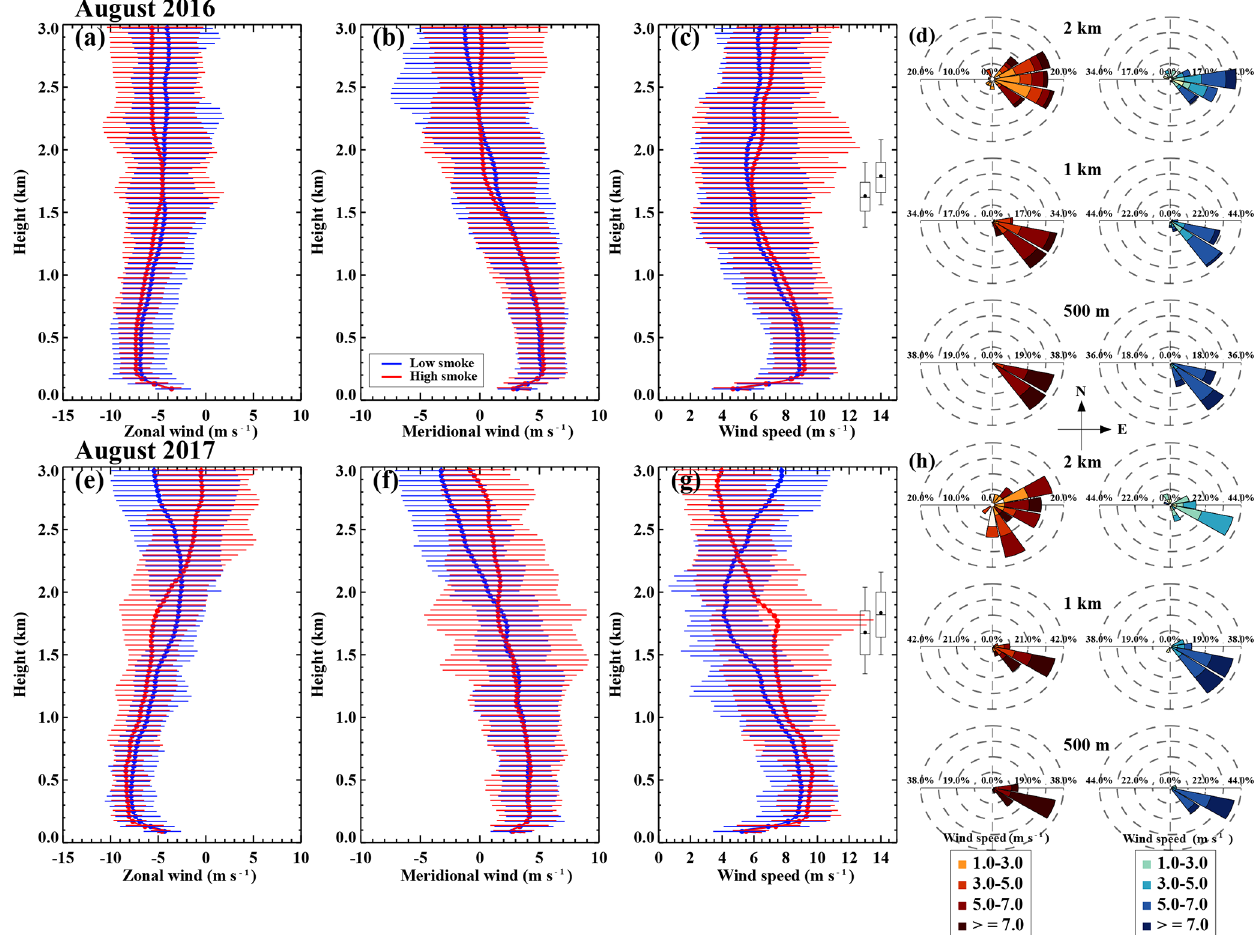
Figure 17. Radiosonde-derived (a, e) zonal wind profiles, (b, f) meridional wind profiles, and (c, g) mean wind speed profiles, for Au- gust 2016 (a–d) and August 2017 (e–h) for “more” (red) and “less” (blue) smoke loadings, respectively. Solid thick curves indicate compos- ite mean, and horizontal bars indicate 10% and 90% percentiles. Inversion bases and tops indicated using mean values (black filled circles), and 10%, 25%, 75%, and 90% percentiles (black box-whiskers) in (c) and (g) . (d, f) Wind roses indicating wind directions at 500m, 1 and 2km for the two years, for days with “more” (left) and “less” (right) smoke.